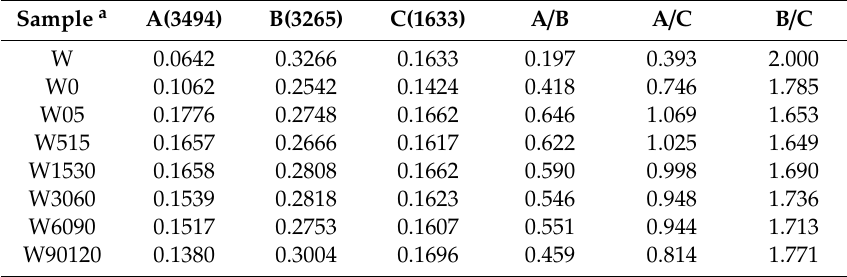
Table 1. Results of the Gaussian distribution of the ν OH in FTIR spectra of deionized water GP-treated under methane for 0 to 120 min.